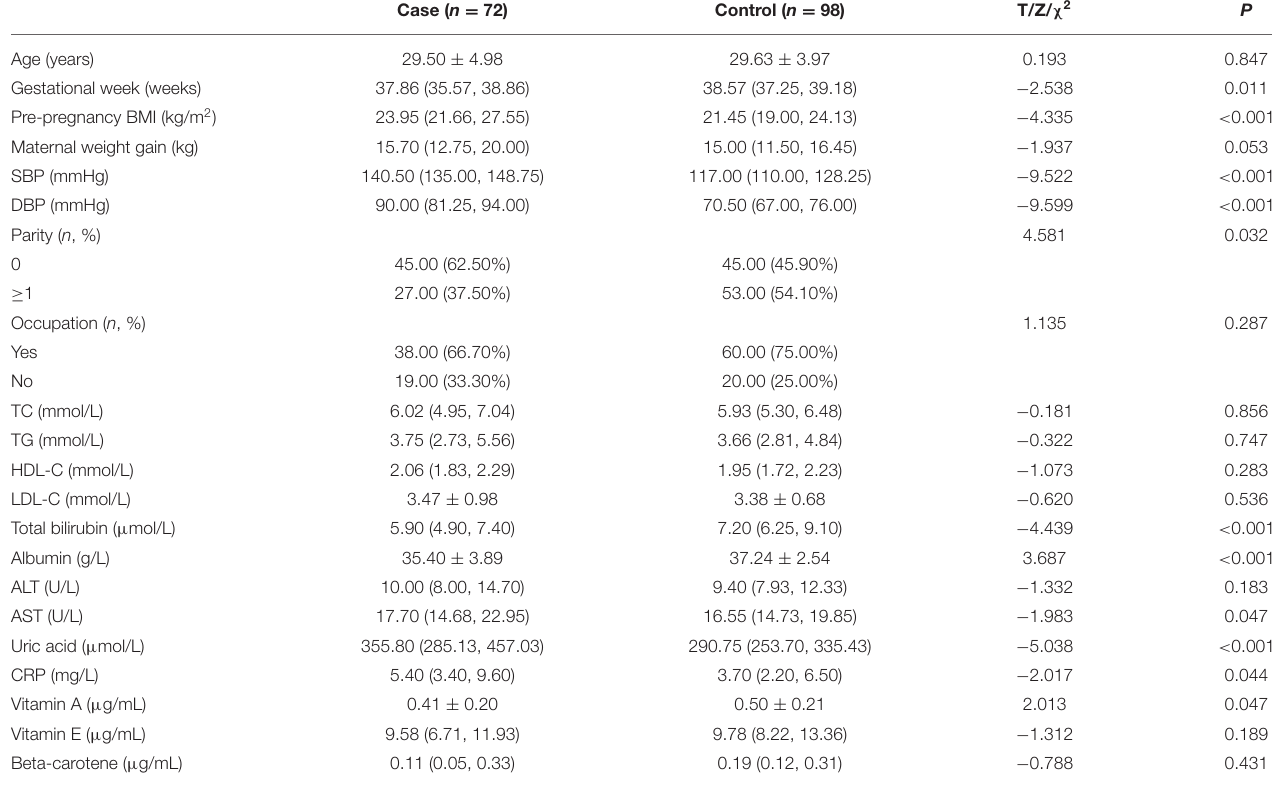
TABLE 1 | Clinical characteristics of the two